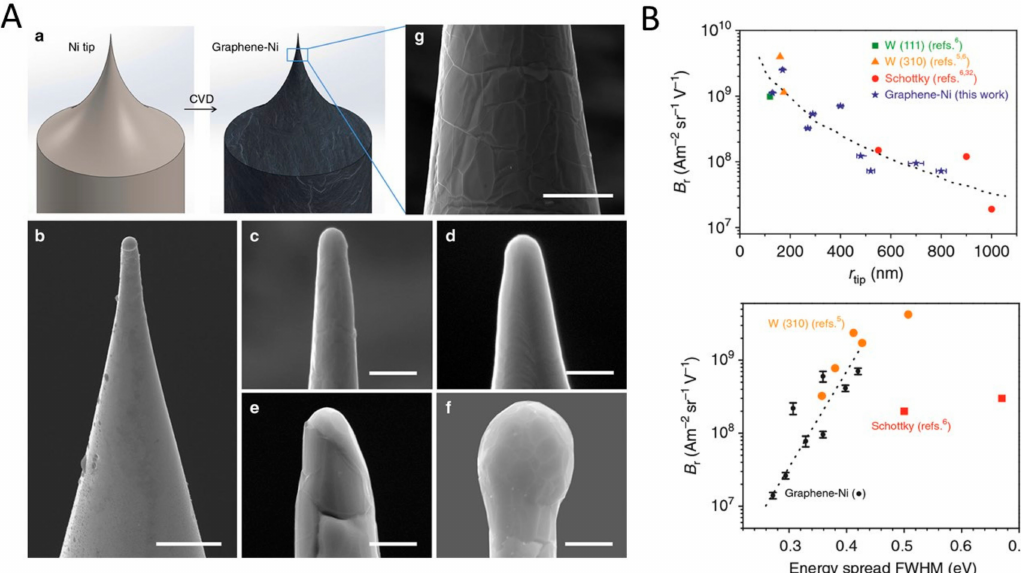
Figure 5. Graphene-coated point cathode field emitter. ( A ) SEM images of graphene-coated point cathode emitter. Reproduced with permission from [77], Copyright Springer Nature, 2018; ( B ) Source brightness and energy spread. Reproduced with permission from [77], Copyright Springer Nature, 2018. CVD: chemical vapor